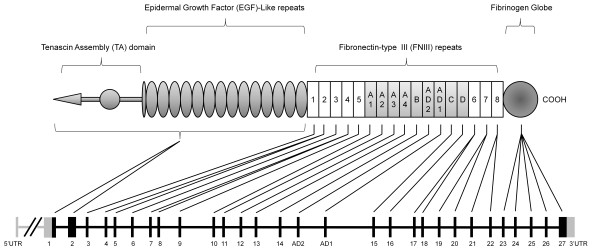
Schematic representation of tenascin-C. Protein structure illustrating the N-terminal tenascin assembly domain, the epidermal growth factor (EGF)-like repeat region, the fibronectin type III-like region and the C-terminal fibrinogen-like domain. Exon organisation is shown below (adapted from [25]). Note that the first exon of TNC is not translated and is shown in grey; therefore, exon number 1 in this figure is the first coding exon. UTR, untranslated region.